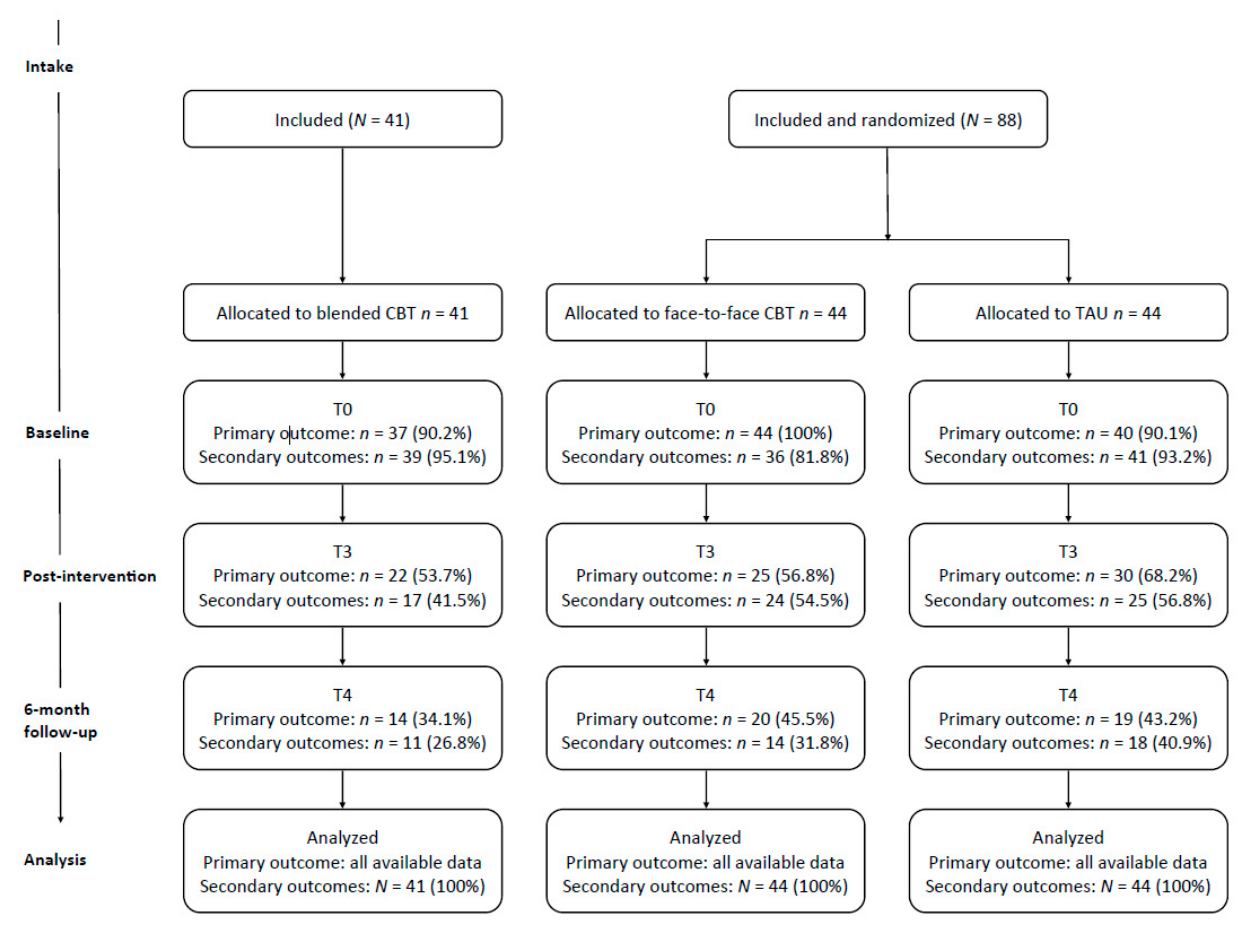
Figure 1. Flow diagram of participants.